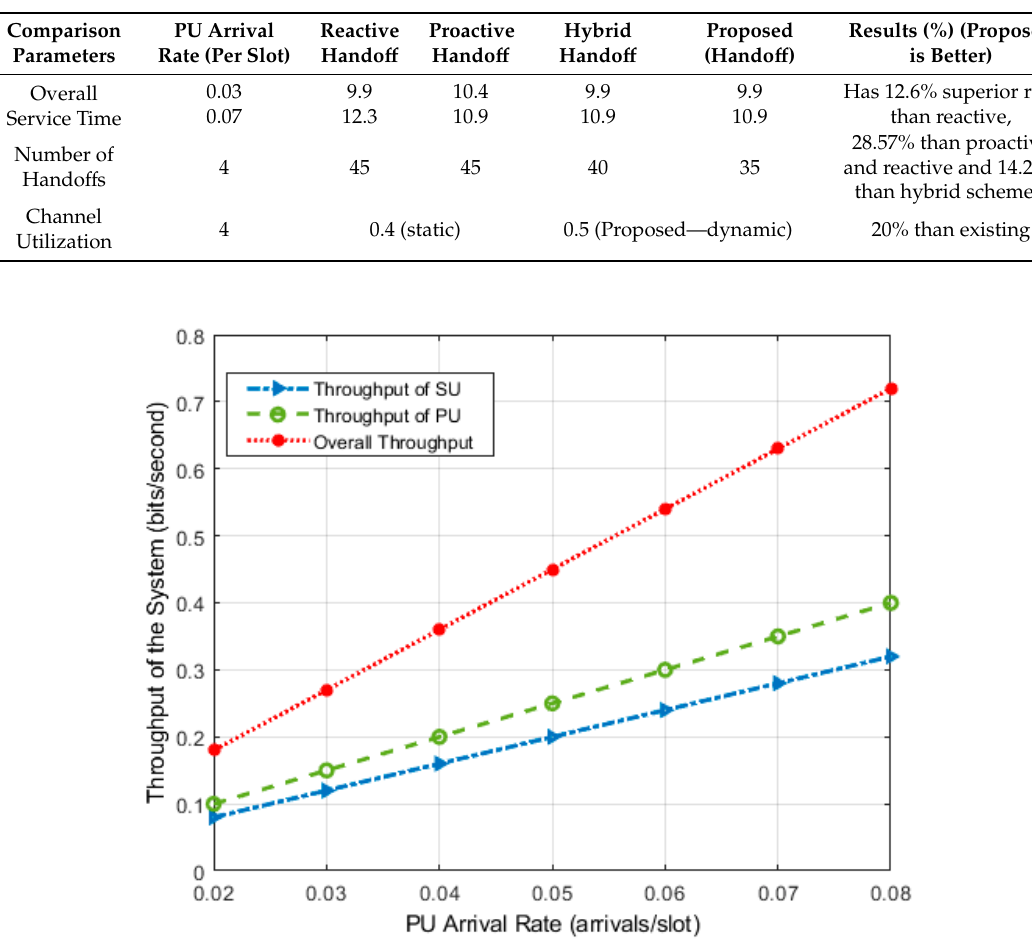
Figure 9. Comparison of PUTPOSH with stationary (reactive and proactive) spectrum access, and hybrid schemes w.r.t. the channel utilization.